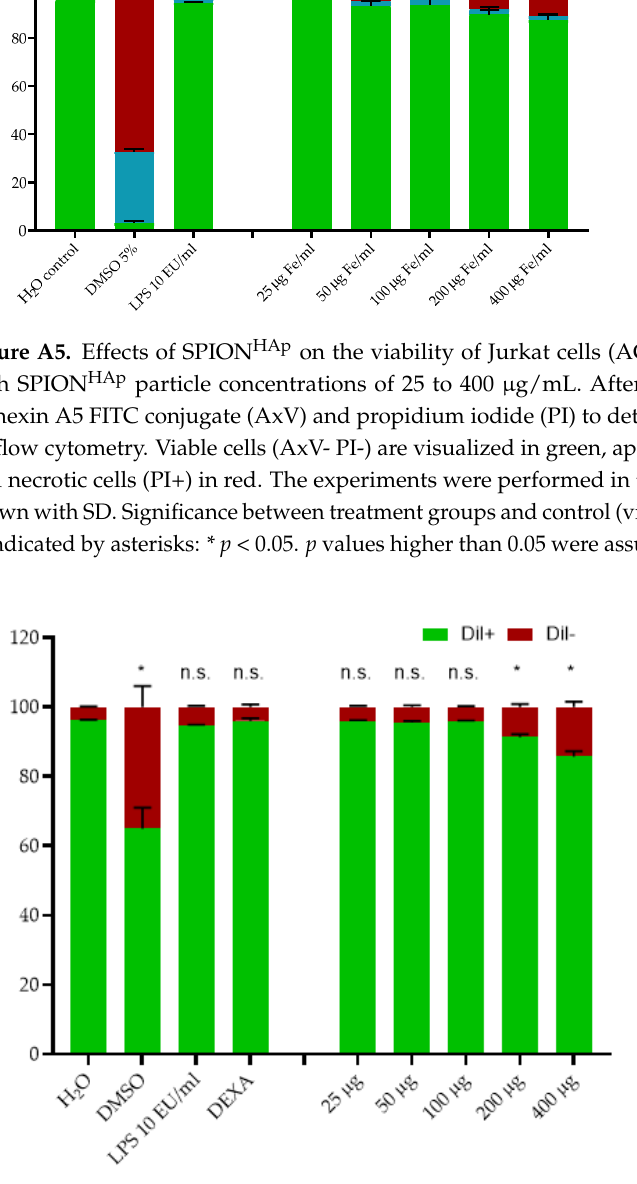
Figure A6. Effects of SPION HAp on viability of EL4 cells (ATCC ® TIB-39™). Cells were incubated with SPION HAp particle concentrations of 25 to 400 µg/ml and additional controls of H 2 O, DMSO 5%, dexamethasone (DEXA) 0.1 µM and LPS. After 24 h cells were stained with Dil-Hoe and evaluated by flow cytometry. Viable cells (Dil+) are visualized in green, apoptotic cells and necrotic cells (Dil-) in red. Each experiment was performed in triplicates. Shown are the mean values with SD. Significance between treatment groups and control (viable cells) at the respective time is indicated by asterisks: * p < 0.05 . P values higher than 0.05 were assumednot significant (n.s.).